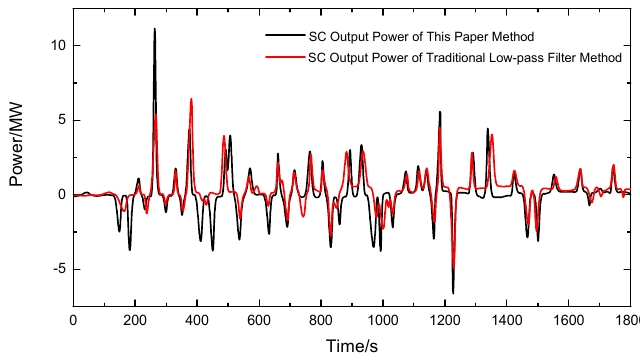
Figure 9. Supercapacitor Output Power.